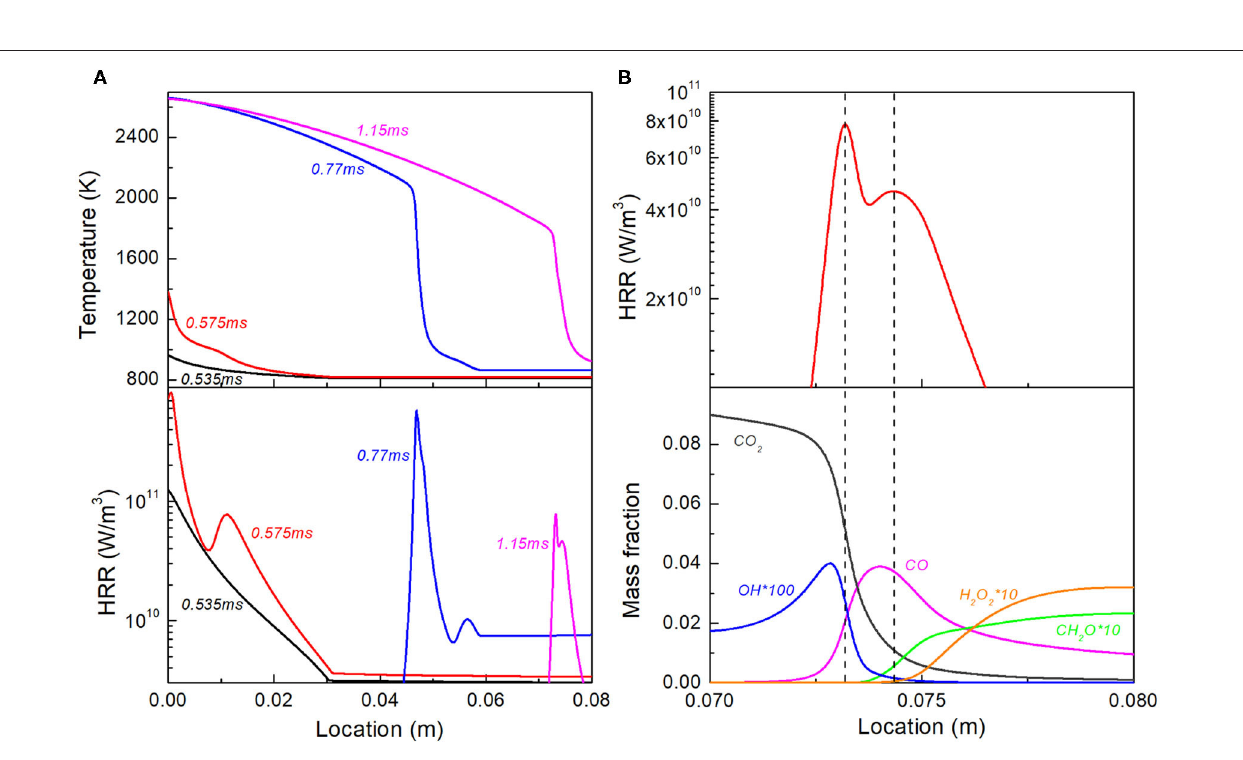
Frontiers in Mechanical Engineering |